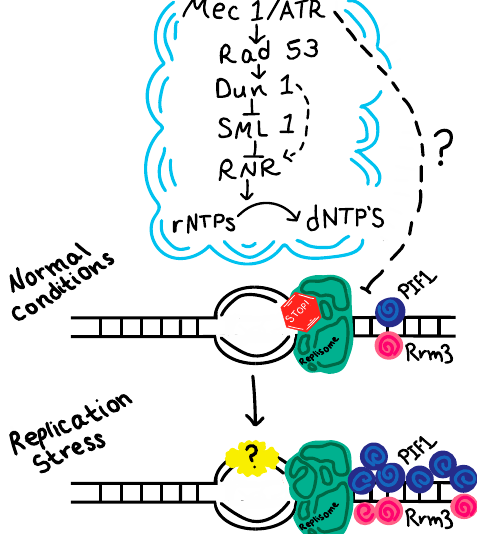
Figure 1. Schematic representation of replication fork protein dynamics during replication stress. A